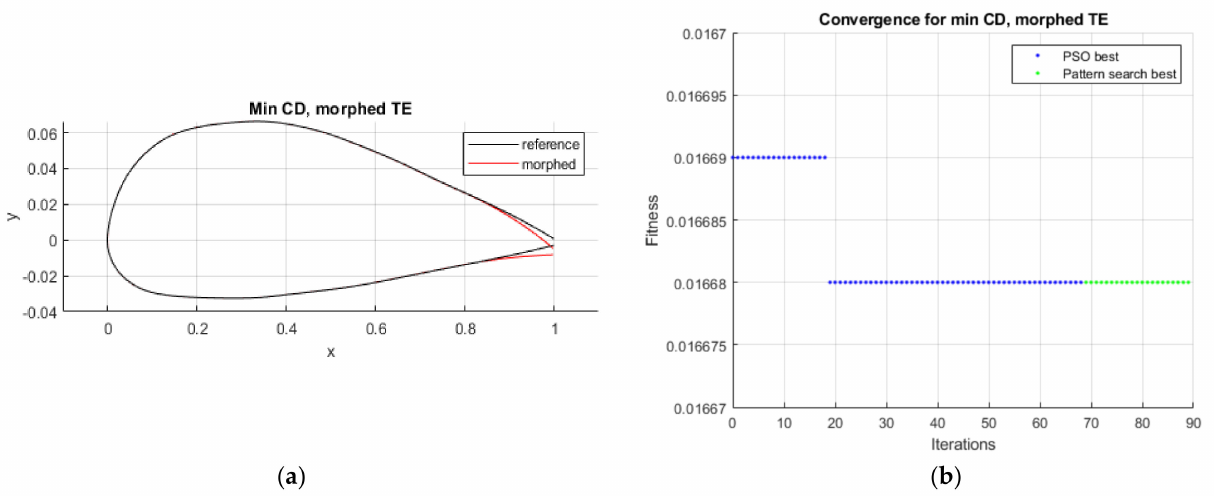
Figure 19. Optimized airfoil and convergence history for drag minimization function. ( a ) the initial (reference) versus the final (optimized or mor-phed) airfoil shape, ( b ) the convergence trend for the minimum drag optimization